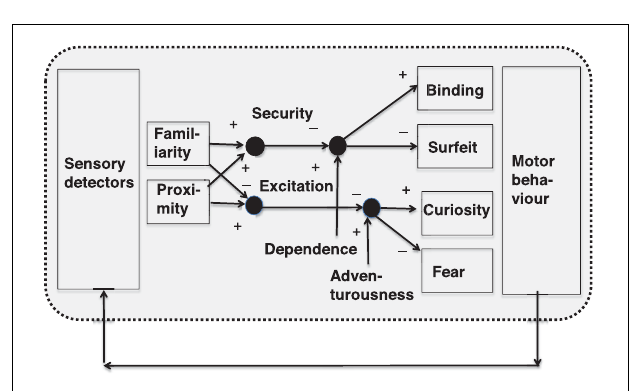
FIGURE 14 | Explanatory circuit model of the latent causal structure of different behavior patterns, by integrative processing of proximity and familiarity of an external object that determines binding behavior and fear and other behavior